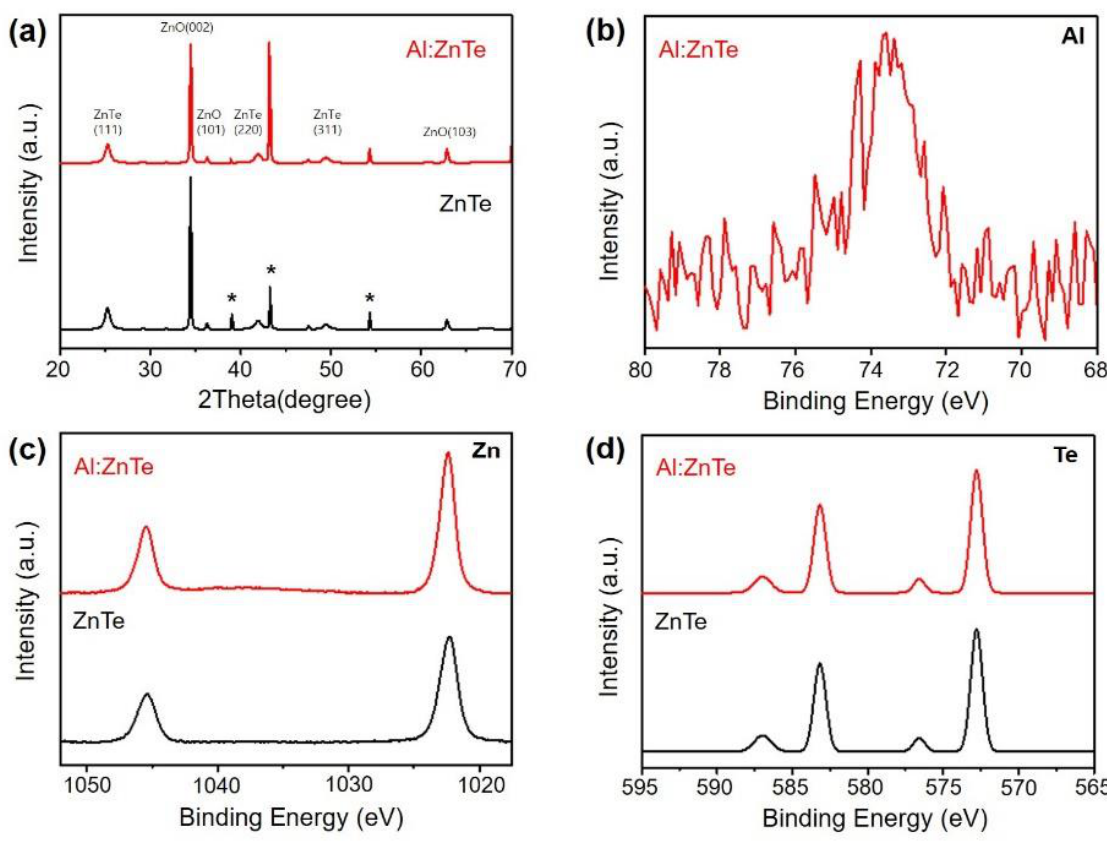
Figure 1. ( a ) XRD patterns, and XPS spectra for ( b ) Al 2p, ( c ) Zn 2p, and ( d ) Te 4f of Al:ZnTe and ZnTe. * indicates XRD patterns of FTO substrates.